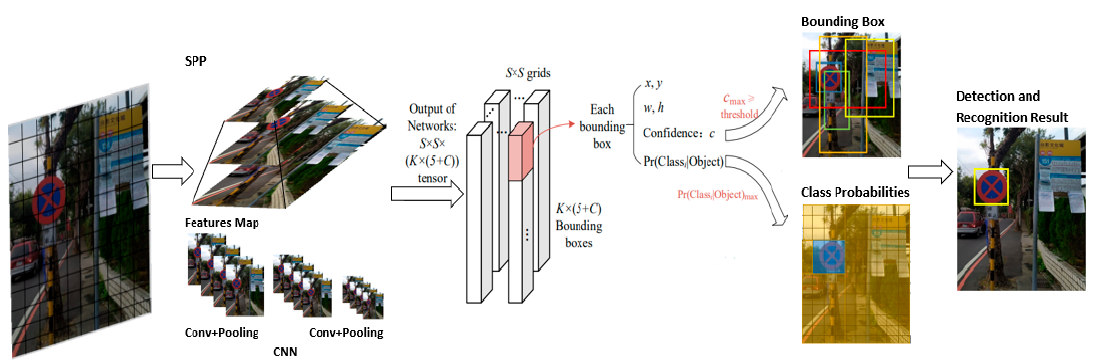
Figure 4. Yolo V3 with spatial pyramid pooling (SPP) architecture.